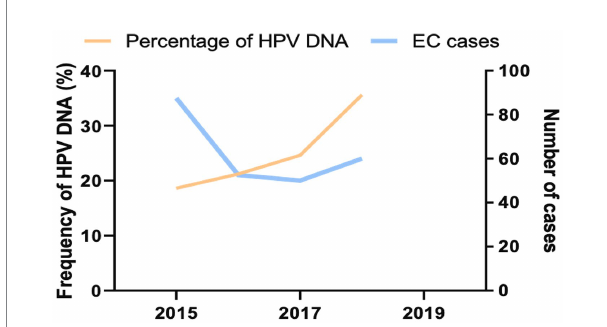
FIGURE 3 Prevalent trends for HPV-infected ECs in northeastern Thailand 2015–2018. The number of all HPV DNA-positive EC (orange) was indicated by the left y axis, while prevalent ECs (blue) were illustrated by the right y